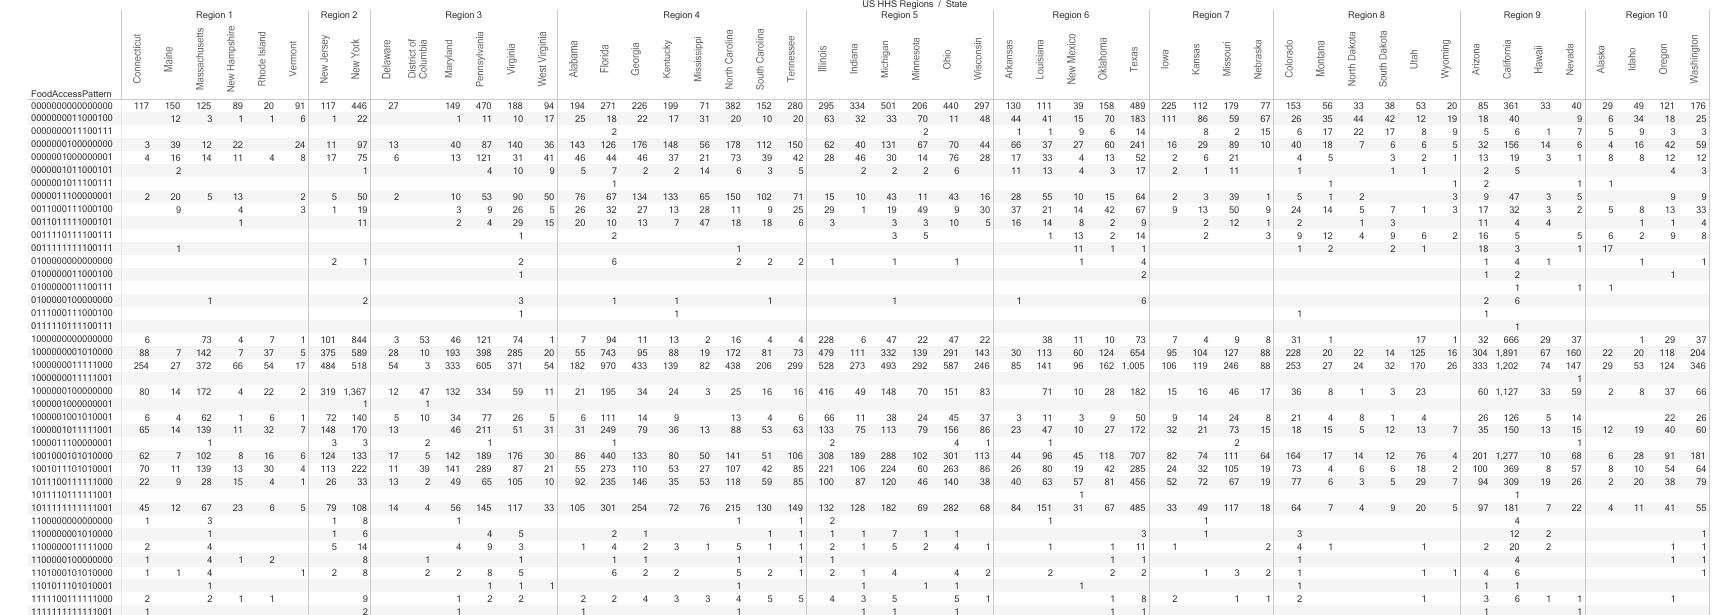
Figure 4. Count of United States census tracts with food access patterns grouped by United States Health and Human Services Regions. We developed a knowledge visualization (enclosure diagram) to transfer knowledge on the overview of census tracts based on counts of the 40 16-digit food access patterns. Binary numbers starting with 1 indicates urban census tract while 0 indicates rural census tract. The grouping of states by 10 U.S. HHS regions is to facilitate decision making especially by researchers interested in comparative analysis of food access measures. The online version of the visualization allows user to view records on census tracts that constitute the count (elaboration and motivation function). The digits in the Food Access Pattern encode 16 variables in the Food Access Research Atlas: Urban, GroupQuartersFlag, LILATracts_1And10, LILATracts_halfAnd10, LILATracts_1And20, LILATracts_Vehicle, HUNVFlag, LowIncomeTracts, LA1and10, LAhalfand10, LA1and20, LATracts_half, LATracts1, LATracts10, LATracts20, LATractsVehicle_20. The 4-digit binary number encodes the Low-Income Low-Access (LILA) variables. The abbreviations of the FARA variables are defined in Table 1.